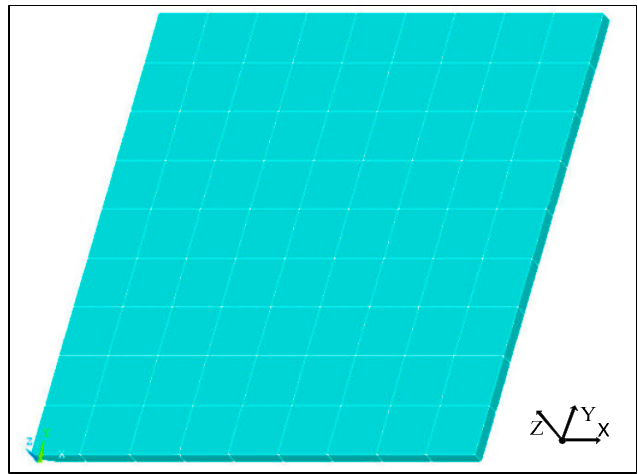
Figure 2. Finite element analysis model of the composite laminate.